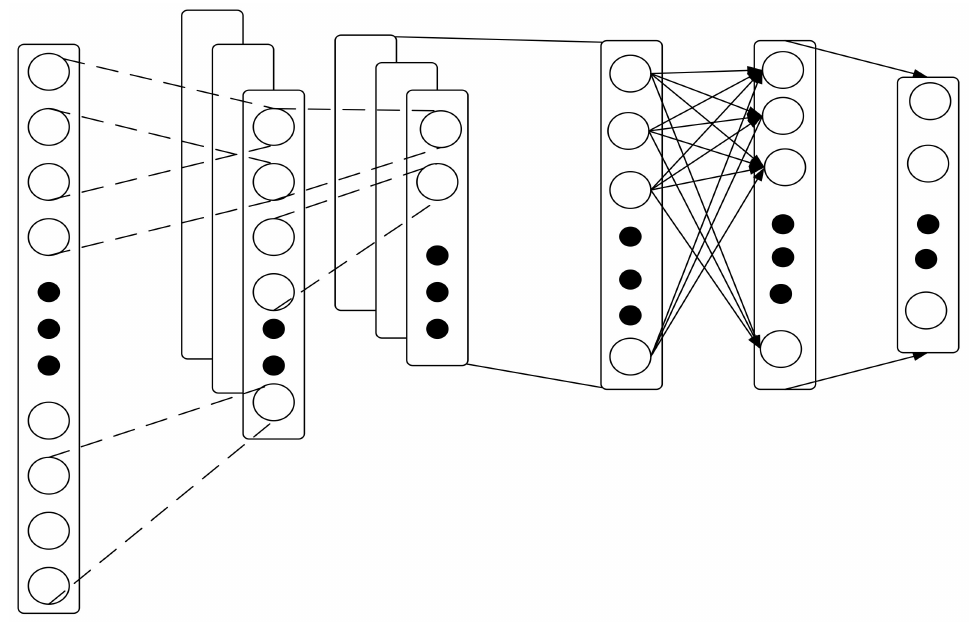
Figure 1. General structure of one-dimensional convolutional neural networks. From left to right: input layer; convolution layer; pooling layer; connection layer; and classification layer.